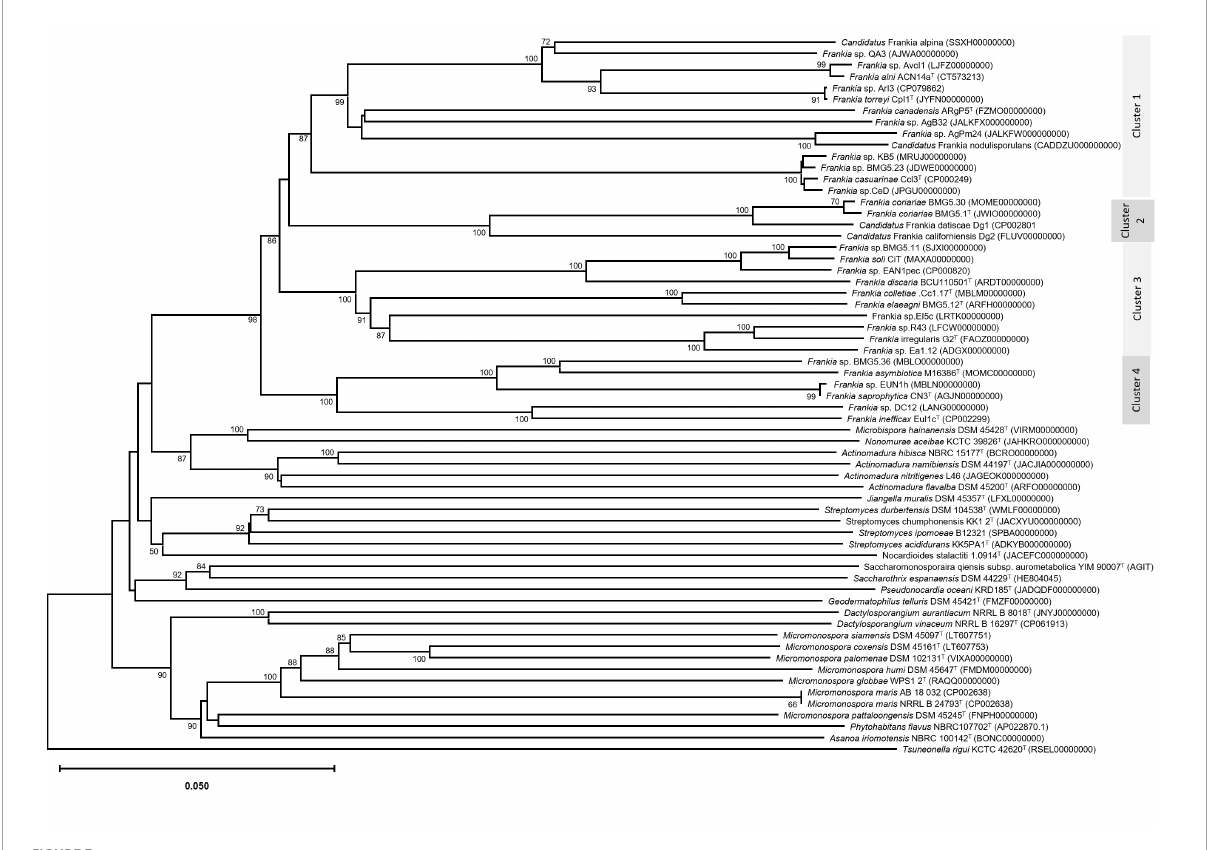
FIGURE3 Phylogenomic tree based on genome sequences in the Type Strain Genome Server (TYGS) tree inferred in FastME 2.1.6.1 (Meier-Kolthoff and Göker, 2019) based on genome BLAST distance phylogeny (GBDP). The branch lengths are scaled based GBDP distance formula d5. The tree was rooted at the midpoint (Meier-Kolthoff et al., 2013). GBDP pseudo-bootstrap support values > 60% from 100 replications, with average branch support of 93.7% were